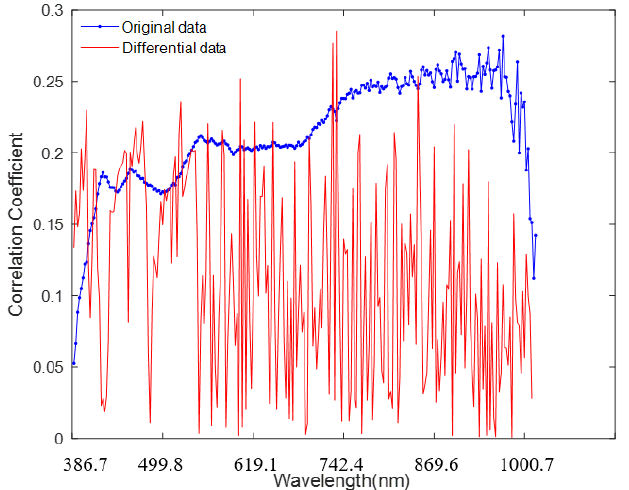
Figure 6. The correlation between the hyperspectral data/first-order difference and the seedling root